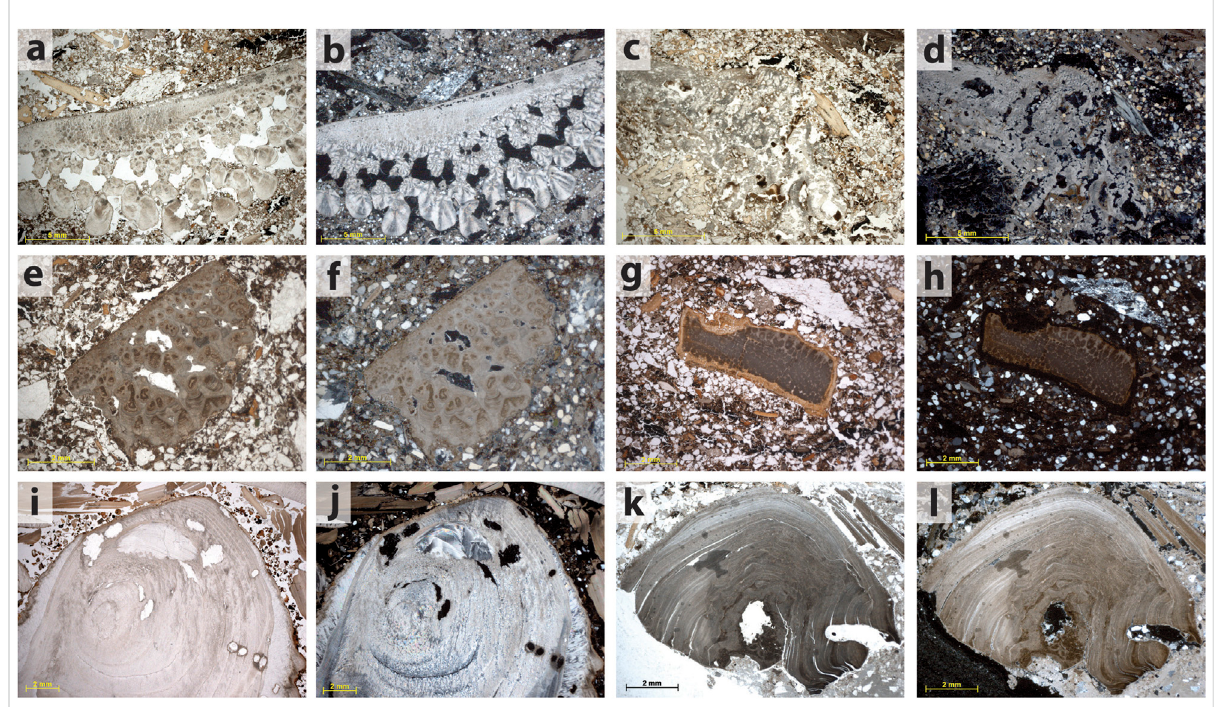
FIGURE 9 Differential preservation of opercula. (A) A well-preserved operculum from sample KRM-15-112, collected from the lateral equivalent of the SBLS. The inner part is oriented downwards. Porosity here is original. PPL. (B) Same view as (A) , XPL. The birefringence of the carbonate, and original crystallite orientation fabric indicates that theshell has not beenchemically altered. μ FTIR analyses indicate that all parts are composed of aragonite. Inner part oriented downwards. (C) A partially dissolved, recrystallized and compressed operculum from sample KRM-13-08, collected within the LBS. PPL. (D) Same view as (E) , XPL. The porosity here is secondary, and nearly all of the original crystallite orientation fabric is lost, but the compositionisaragonite. (E) AnalteredoperculumfromsampleKRM-13-05, collectedfromthecontactbetweentheSBLSandtheLBS.Thecolorin PPL indicates possible heating, and the composition is calcite. Inner part oriented downwards. PPL. (F) Same view as (C) , XPL. The matrix contains quartz and carbonate sand, as well as ashes. (G) A different altered operculum, also from sample KRM-13-05, just below the contact between the SBLS and theLBS. The outer edge of thefragmenthas been replaced by secondary hydroxyapatite, con fi rmedwith μ FTIR. PPL. (H) Same view as (G) , XPL. The matrix contains little carbonate and is enriched in microcharcoal and organic material. (I) A well-preserved operculum from sample KRM- 15-103. This operculum — located in the eastern side of Cave 2 — is composed of aragonite. The orientation of the cut is perpendicular to that of the previous images. PPL. (J) Same view as (I) , XPL. (K) A burnt operculum from sample KRM-13-07. The orientation of the cut is similar to that of (I) and (J) . PPL. (L) Same view as (K) , XPL. The matrix is